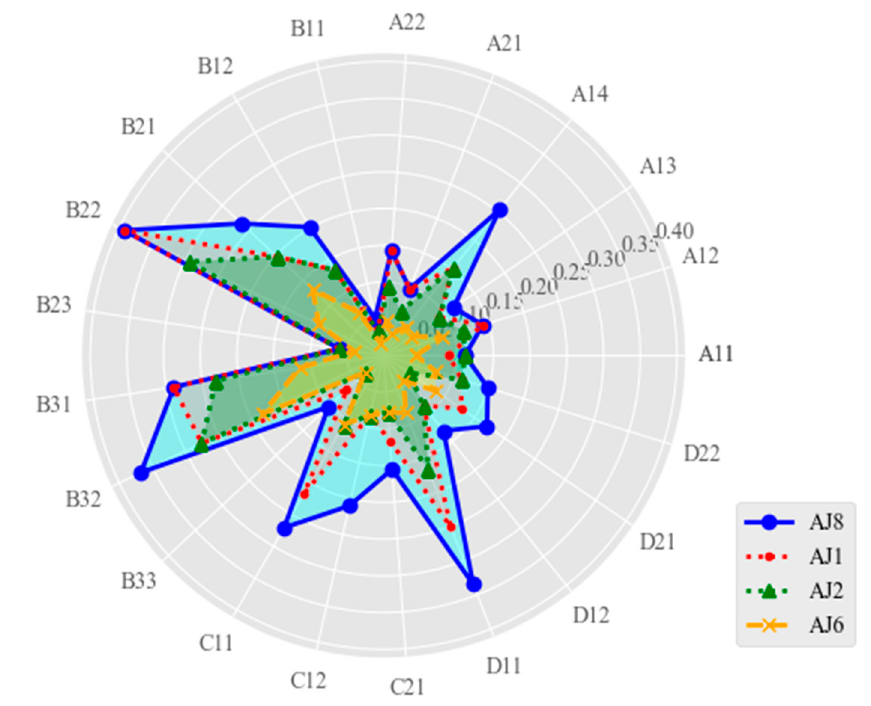
Figure 12. Comparison of evaluation indicators of chair industry enterprises (partial data).